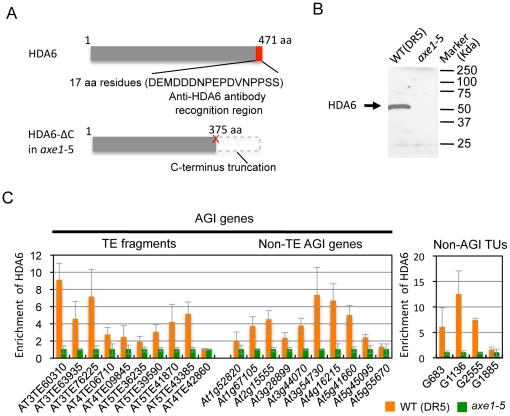
Identification of direct targets of HDA6 using an HDA6-specific
antibody.(A) Schematic illustration of HDA6-specific antibody raised in this
study. The point mutation in axe1-5
[33],
is indicated by a red cross and the resulting C-terminal truncation of
the HDA6 protein in axe1-5 is indicated by a dashed
box. The 17 amino acid (aa) peptide selected for the epitope is
indicated by a red box, which is absent in axe1-5. (B)
Western blot analysis indicates high specificity of the HDA6 antibody
for its target. Total protein extracts from wild-type (WT) and
axe1-5 plants were analyzed to check the
specificity of the HDA6 antibody. (C) Screening of HDA6 direct targets
by ChIP-qPCR assay. The transcribed regions of 22 selected loci from
those derepressed in axe1-5 (Figure
S1), including 9 AGI annotated TE fragments, 9 non-TE AGI
genes and 4 non-AGI TUs were used in this study. AGI annotated TE
fragments are as follows: AT3TE60310 (At3g42658),
AT3TE63935 (At3g44042), AT3TE76225
(At3g50625), AT4TE06710
(At4g02960), AT4TE09845 (At4g04293),
AT5TE36235 (At5g27927), AT5TE39590
(At5g28880), AT5TE41870
(At5g30480), and AT5TE43385
(At5g32566). The loci down-regulated in
axe1-5 (AT4TE42860: At4g16870),
and a gene with no apparent transcriptional difference between
axe1-5 and WT (At5g55670) were
included in this screening. Equal amounts of the input DNA and the
immunoprecipitates were analyzed and normalized against the input DNA.
The values obtained were normalized with ACT2 and the
relative enrichment of HDA6-binding in the wild-type plants compared
with axe1-5 is shown as the mean and standard
deviations obtained from three independent immunoprecipitates (orange,
WT; green, axe1-5).